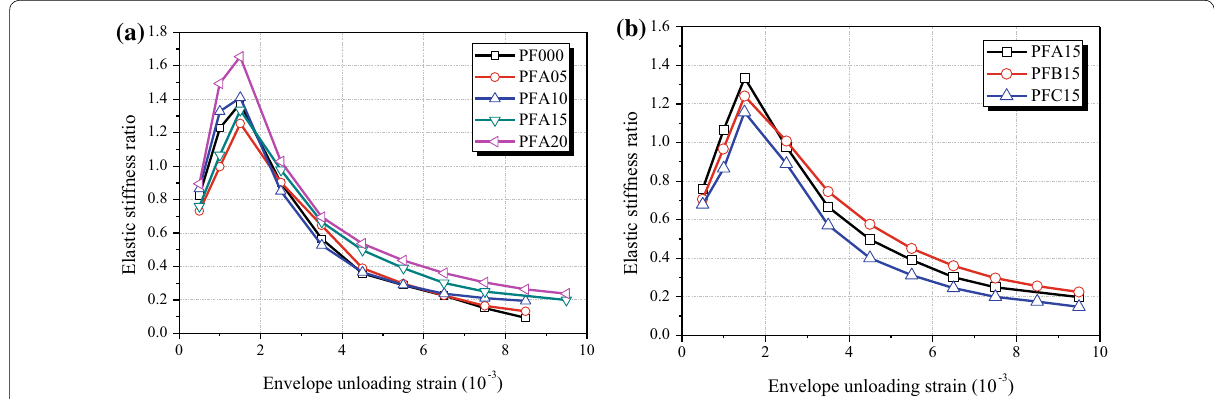
Fig. 12 Relation between elastic stiffness ratio and envelope unloading strain of concrete. a Effect of fiber volume fraction. b Effect of fiber aspect ratio.